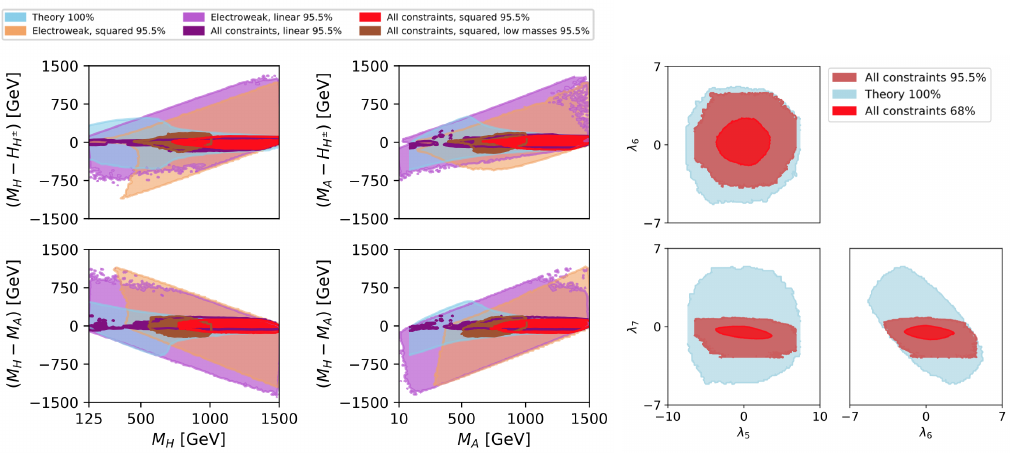
Figure 2. Left panel: allowed regions for the scalar mass splittings coming from theoretical constraints at 100% probability (blue), from EWPOs at 95.5% probability (in orange, squared mass priors and in light purple, linear priors), and combining all constraints at 95.5% probability (linear mass priors in purple, squared mass priors in red and squared mass priors with lower masses in brown). The “All constraints” contains only the right-sign branch discussed in section 4.5. Right panel: two-dimensional bounds on the λ 5 , λ 6 and λ 7 parameters of the potential resulting from imposing theoretical constraints (blue, 100% probability), and considering all constraints (in dark red 95.5% probability, in red 68%